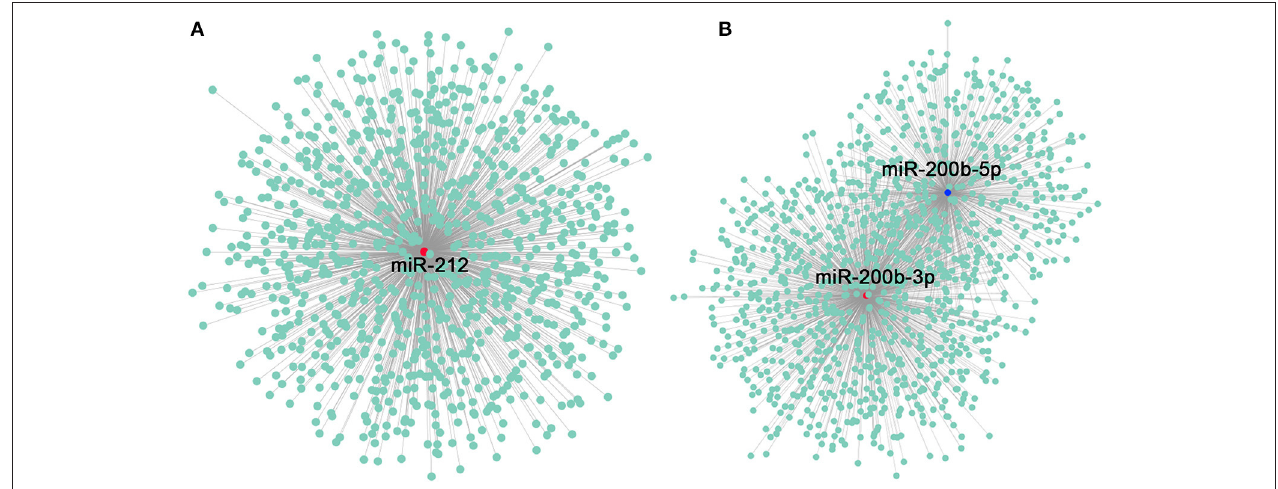
FIGURE 5 | Construction of miRNA-212–circRNA and miR-200b–circRNA networks. (A) miRNA-212–circRNA network constructed using Cytoscape. The red dot indicates miR-212, and the green dots indicate the related circRNAs. (B) miR-200b–circRNA network constructed using Cytoscape. The red dot indicates miR-200b-3p, the blue dot indicates miR-200b-5p, and the green dots indicates the circRNAs as miRNA